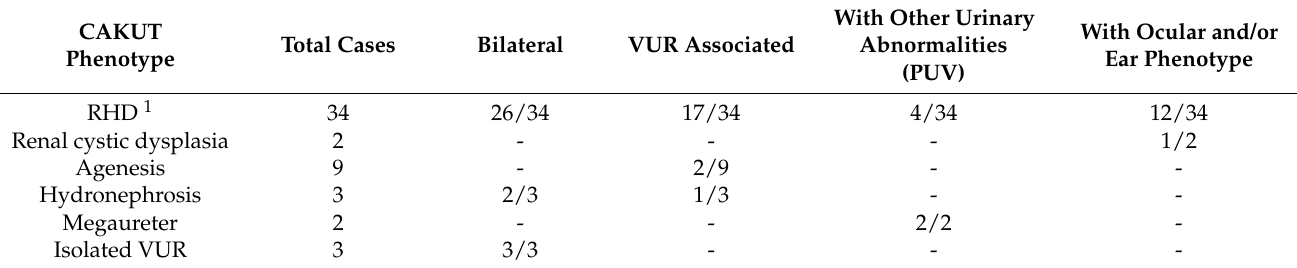
Table 1. Renal and ureteral phenotypes of the pediatric